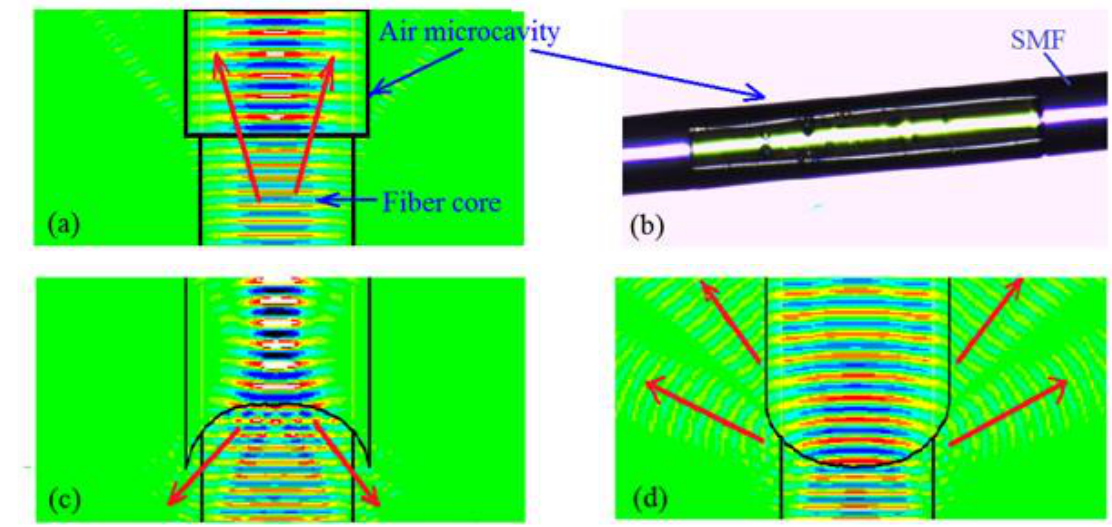
Figure 3. Analysis of the reflecting surface I based on FDTD. ( a ) Parallel reflecting surface I. ( b ) Microscope image of F-P with parallel reflector. ( c ) Concave reflecting surface I. ( d ) Convex reflecting surface I. (SMF: Single mode fiber; the refractive index of the core is 1.4679; the refractive index of the cladding is 1.4613; the refractive index of air is 1; incident light wavelength is 1550 nm; Light: .)